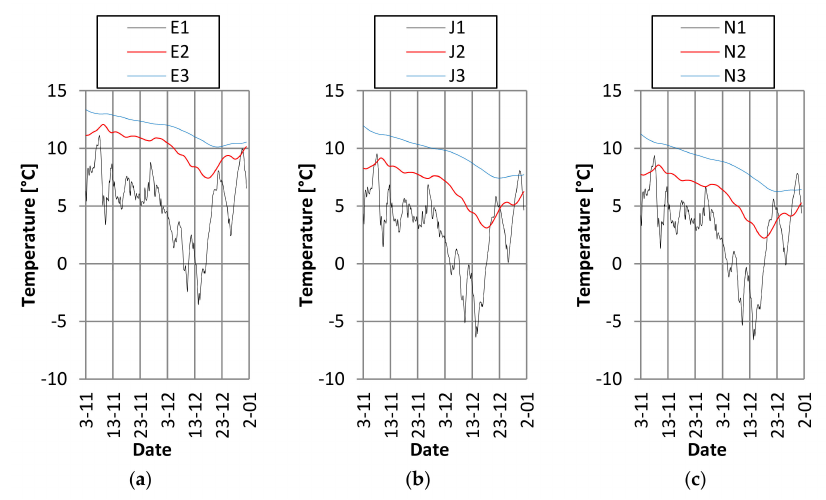
Figure 4. Soil temperature in lines E, J, and N on selected days during the autumn season.